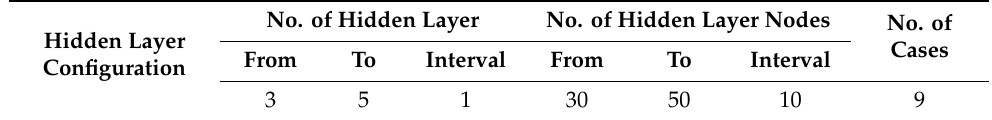
Table 4. Hidden layer configuration for DNN model